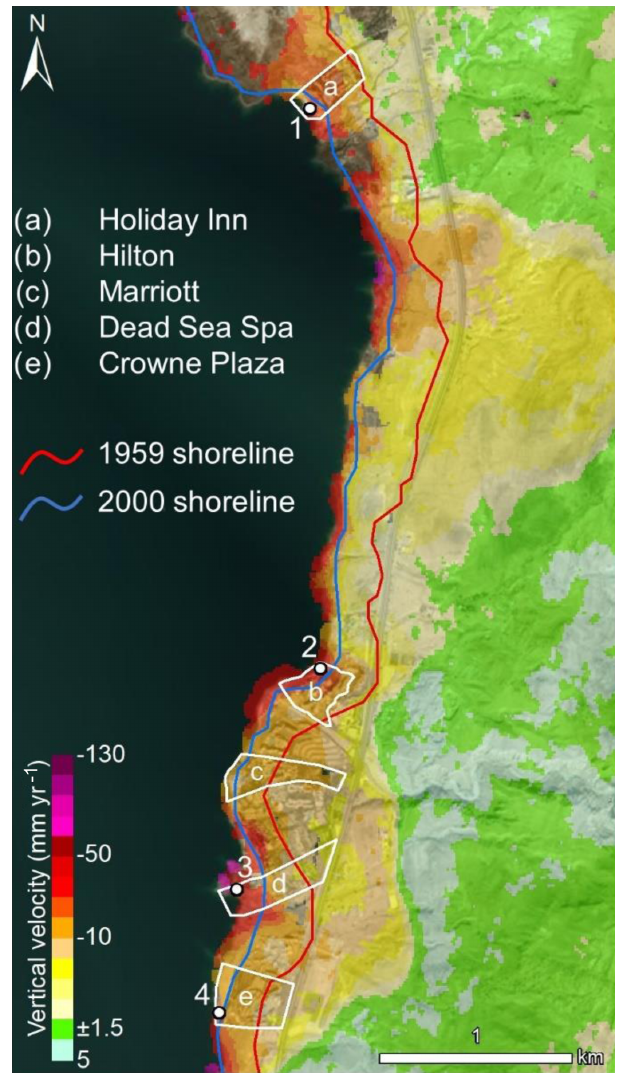
Figure 4. Vertical velocity map of the study area obtained from the SBAS processing of Sentinel-1A/B images. The white dots labelled with numbers are the points selected to extract the displacement time series presented in Fig.